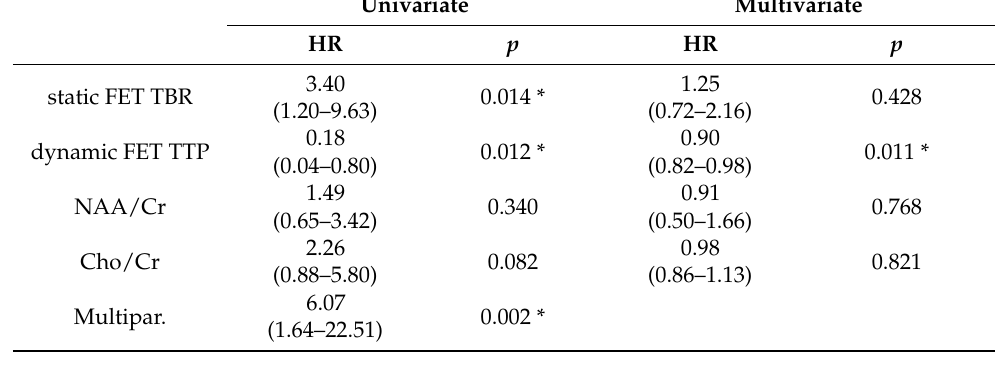
Table 4. Univariate (Kaplan–Meier) and multivariate (Cox regression) correlation between OS and imaging parameters. Significant results are marked with an asterisk.